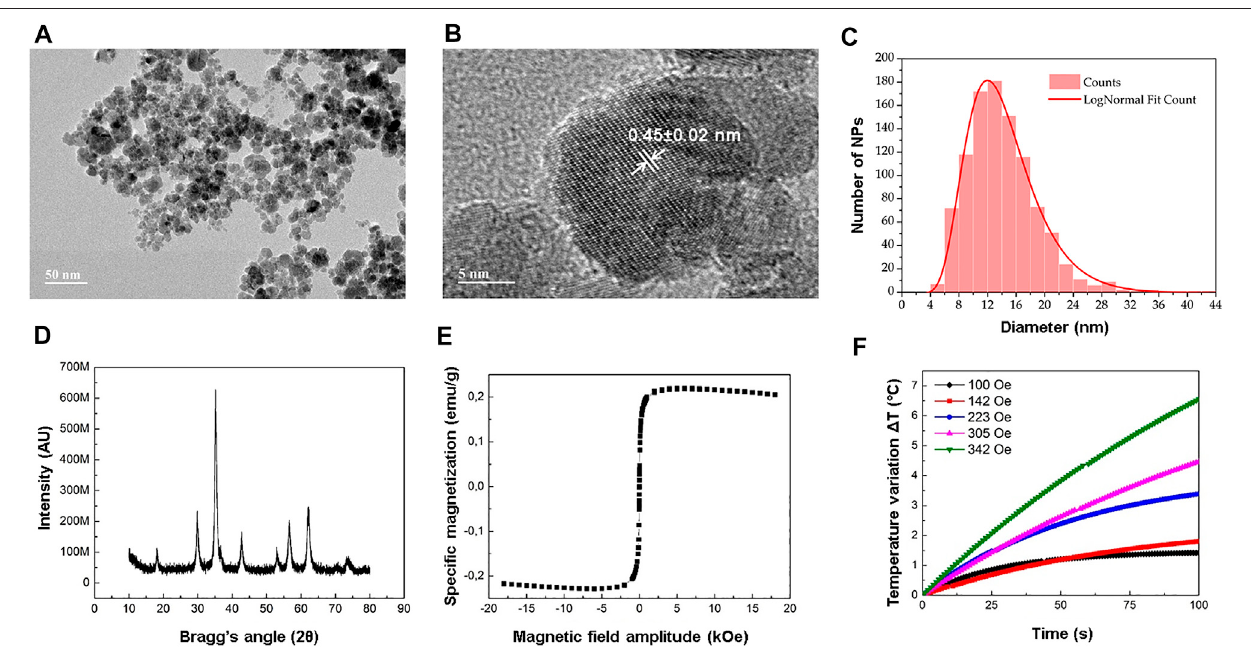
FIGURE 1 | MnFe 2 O 4 NPs characterization. (A) Typical TEM image of an aqueous (ammonium sulfate buffer) dispersion of MnFe 2 O 4 NPs dried on the surface of a TEM sample holder (grid). Scale: 50 nm. (B) High resolution TEM image of a typical NP, evidencing its crystallographic planes and roughly spherical morphology. Scale: 5 nm. (C) Frequencycount( N =1,000)ofTEM-imagedNPs.Meandiameter=14.4±5.2nm,obtainedviaalog-normal fi tofthediameterdistribution. (D) XRDspectrum of powder-dried NPs. Mean diameter = 13.5 nm, obtained via Debye – Scherrer equation. (E) Typical magnetization pro fi le of NPs displaying superparamagnetic behavior (no hysteresis), obtained via VSM. Magnetic concentration = 4.5 mg/ml, calculated via Eq. 1 . (F) MHT pro fi les used to calculate the NPs magnetothermal conversion ef fi ciency (i.e., their speci fi c loss power, SLP) via Eq. 2 , for different AC magnetic fi eld amplitudes. AC magnetic fi eld frequency = 334 kHz. See Supplementary Table S1 for the corresponding SLP